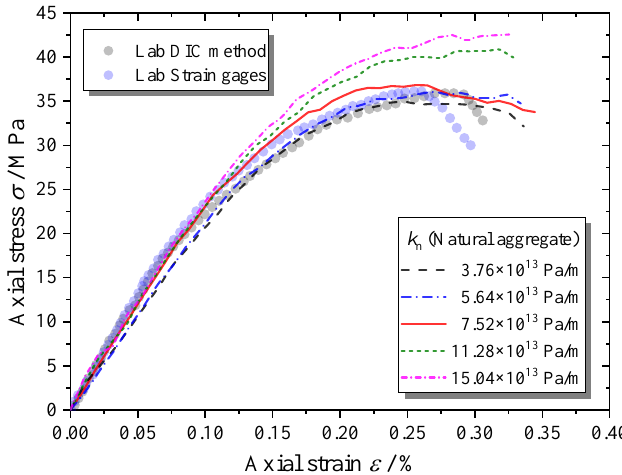
Figure 21. Complete compressive stress–strain curves of MRAC specimen with various natural